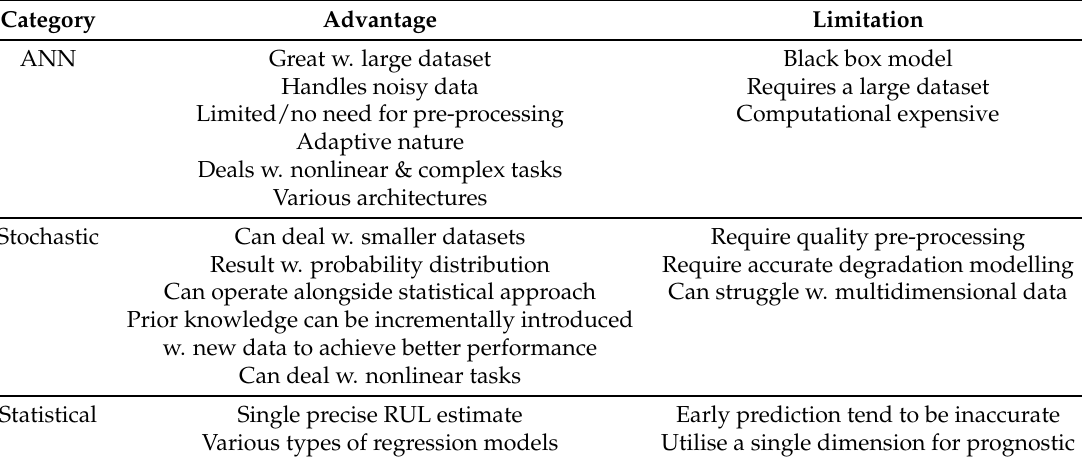
Table 3. An overview of some of the general advantages and limitations of the algorithms within the given categories [22,63]. As individual algorithms present their own set of strengths and weaknesses the reader is recommended to study the individual algorithm as